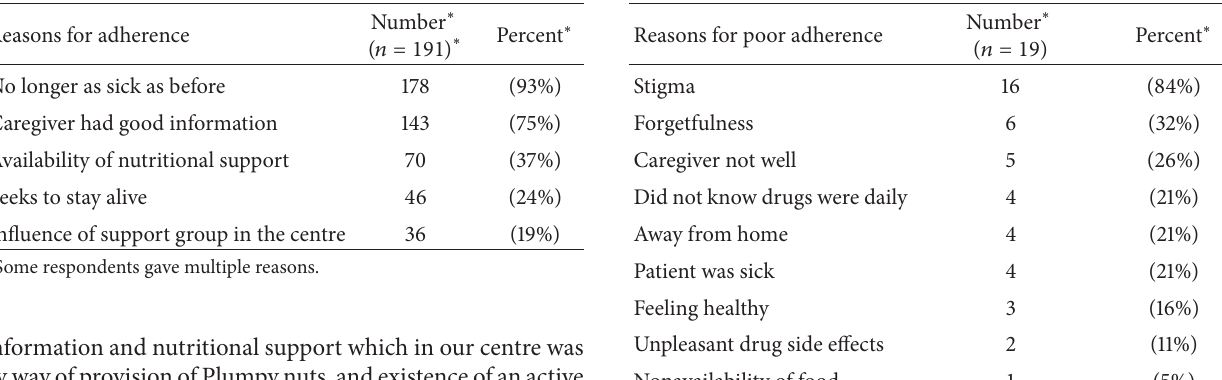
Table 3: Reasons given by patients/caregivers for poor